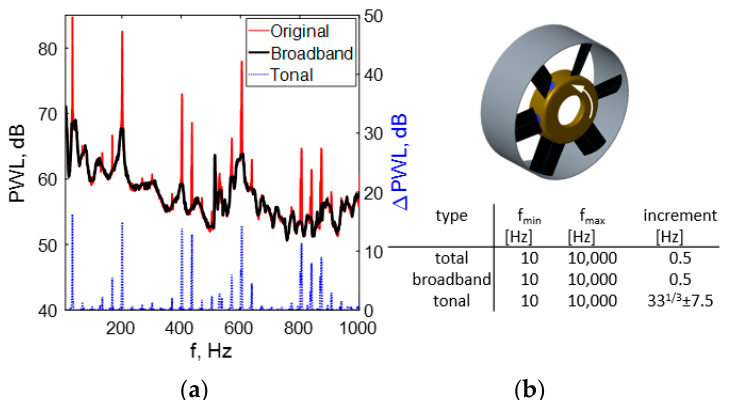
Figure 7. ( a ) Example of a sound power level spectrum for the baseline rotor with applied filters, separating tonal and broadband effects; ( b ) Boundary conditions of customized filters [16].